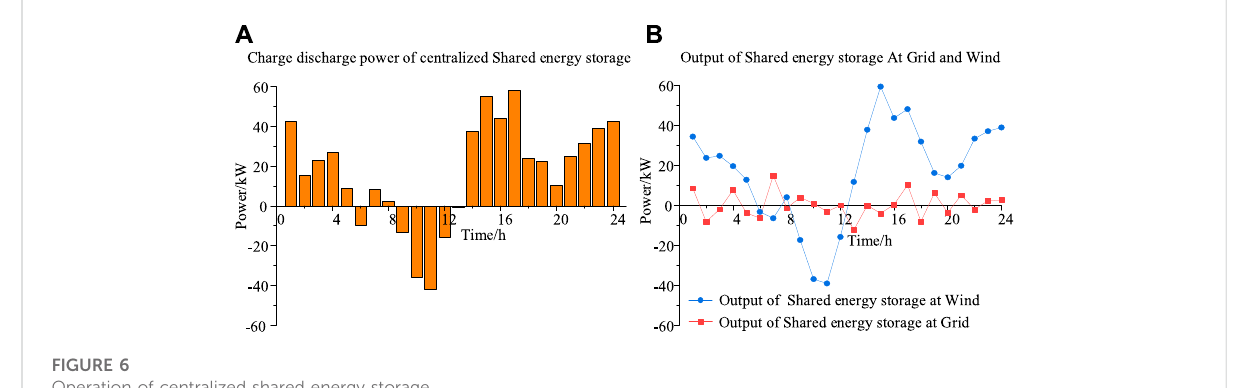
FIGURE 6 Operation of centralized shared energy